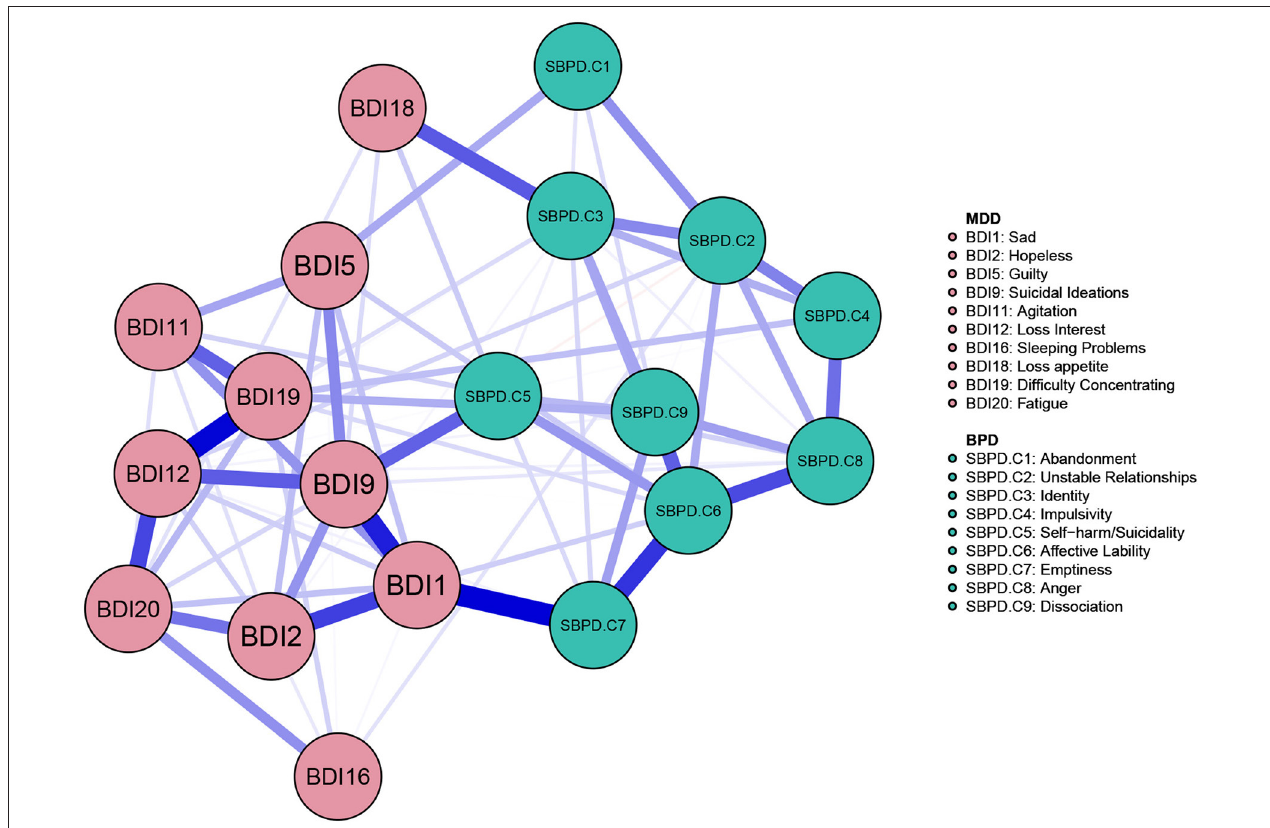
FIGURE 2 | Network of the BPD and MD symptoms. Symptom groups are differentiated by color. Each edge within the network corresponds to a regularized partial correlation between 2 individual symptoms, after controlling for all other symptoms in the network. The thickness of an edge represents the absolute magnitude of the correlation (thicker edges represent stronger links), whereas the color of the edge indicates the size of the correlation (blue for positive links and red for negative